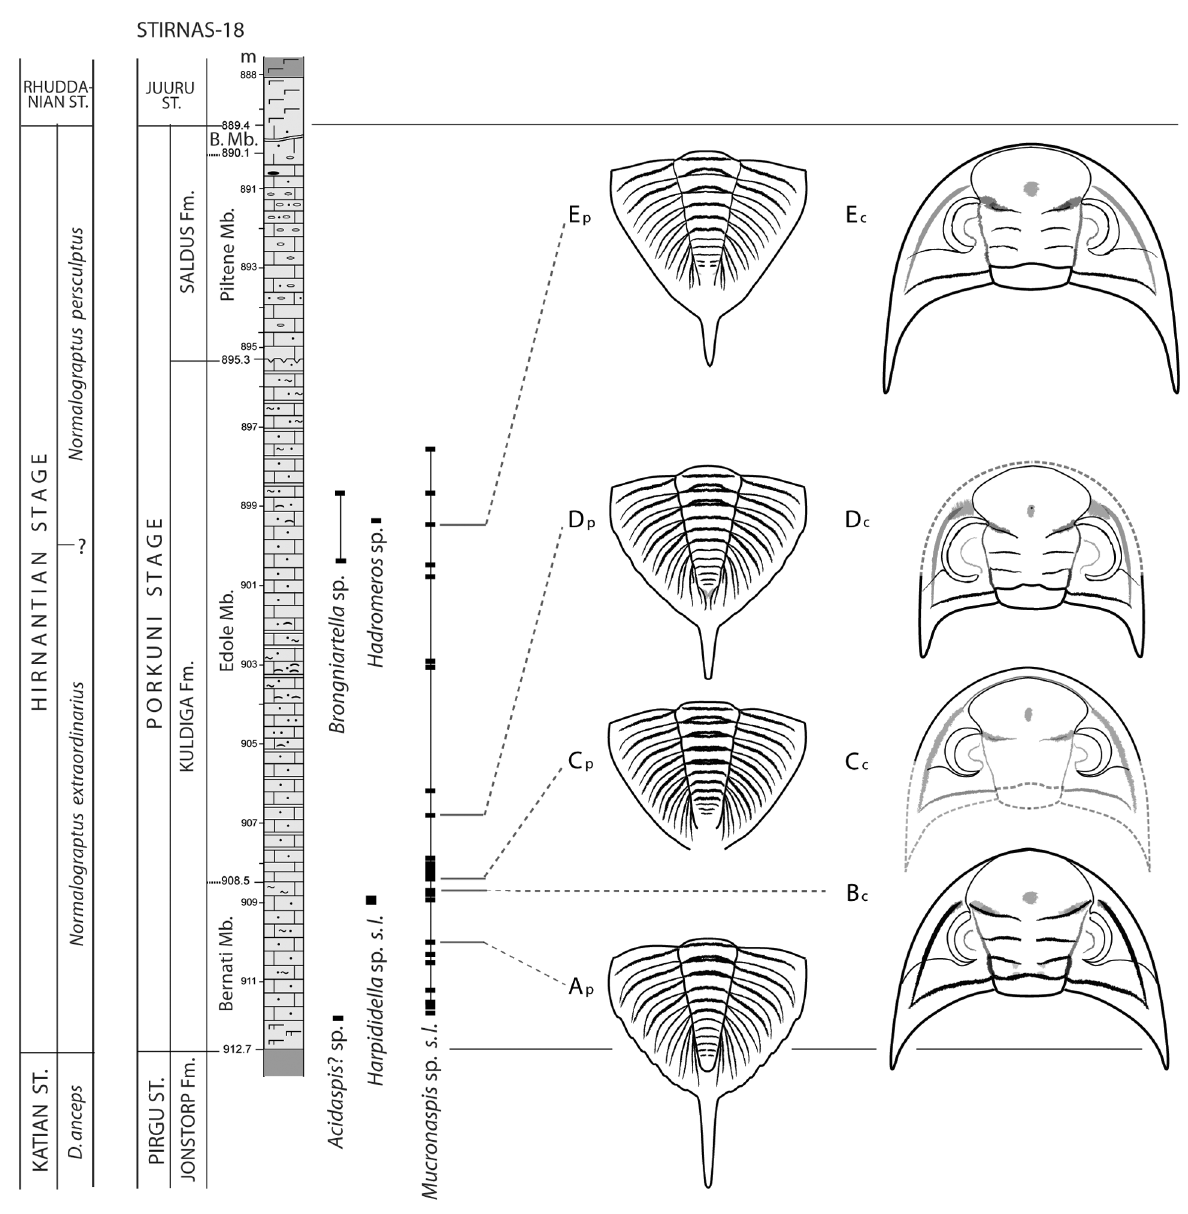
Fig. 3. Distribution of trilobites in the Stirnas-18 drill core section and the morphs of Mucronaspis mucronata (Brongniart) s.l . (cid:150) A p (pygidium GIT 585-3-1), B c (cephalon GIT 585-6-1), C p (pygidium GIT 585-7-1), C c (cephalon GIT 585-8-1), D p (pygidium GIT 585-10-1), D c (cephalon GIT 585-9-1), E p (pygidium GIT 585-11-1), E c (cephalon GIT 585-12-4). For description of the section and correlation with the global units see Hints et al. (2010). D. , Dicellograptus ; St., Stage; Fm., Formation; Mb., Member; B.,